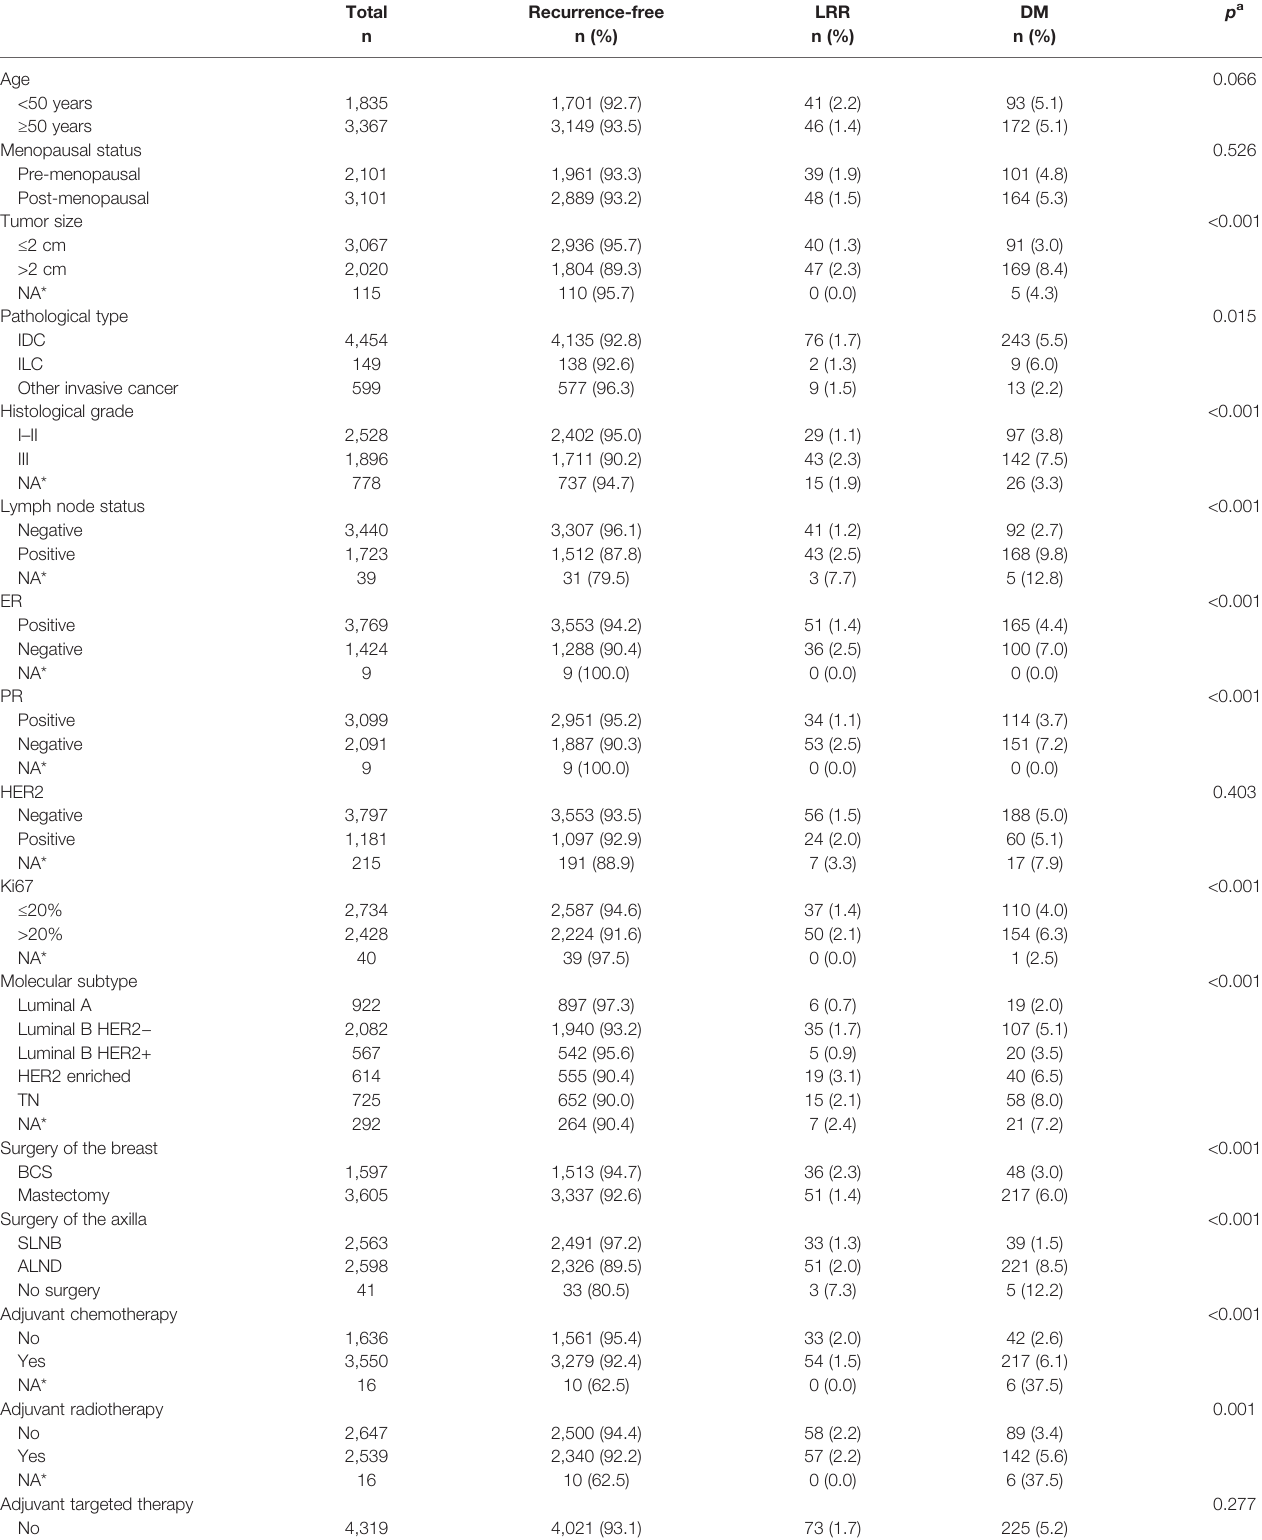
TABLE 1 | Clinicopathological characteristics at initial diagnosis and treatment for primary breast cancer by different fi rst recurrence